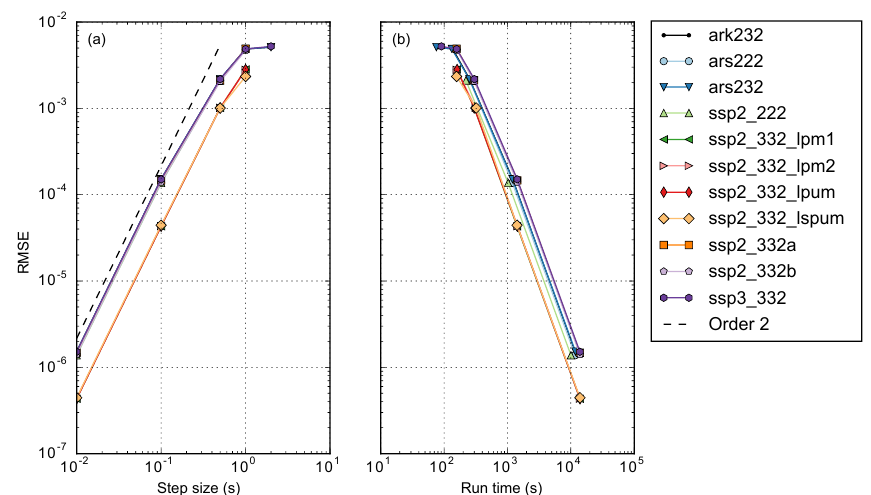
Figure 1. Accuracy (a) and efficiency (b) for the second-order methods using the Rosenbrock-like approach with the HEVI-A splitting. The dashed line represents second-order convergence. The ARK methods fall into two groups with similar accuracy. Results using multiple New- ton iterations to compute the stage solutions give nearly identical error values to the Rosenbrock-like results but increase the computational cost by 20–50%.